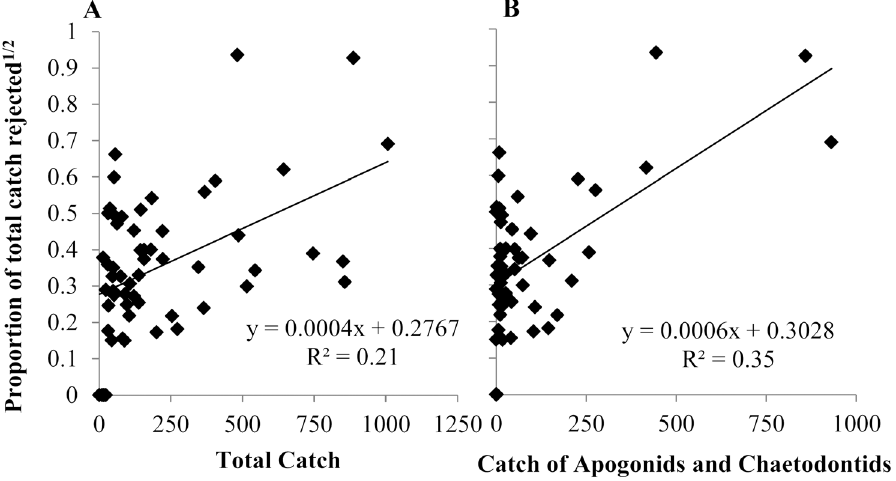
Fig 4. Proportion of total catch rejected (square root transformed) plotted against (A) total catch and (B) catch of apogonids and chaetodontids over the study period for individual fishers.